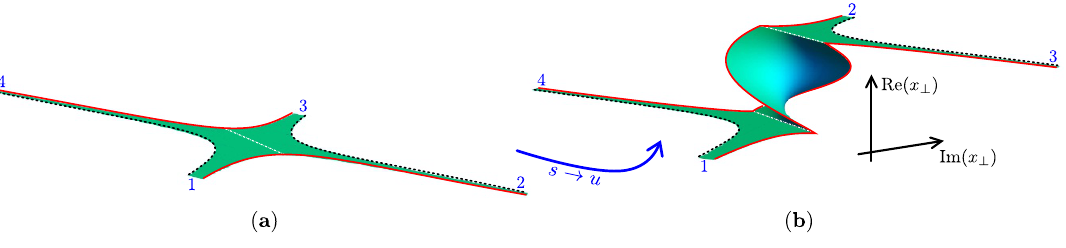
Figure 3 . Analytic continuation that connects the s - and u -channels. a) The original worldsheet with ordered external states Tr V 1 ( k 1 ) V 2 ( k 2 ) V 3 ( k 3 ) V 4 ( k 4 ) . b) The worldsheet after the analytic h i continuation s u . This new classical solution can be obtained from the amplitude with ordering → of points 2 and 3 is interchanged Tr V 1 ( k 1 ) V ⊺ ( k 2 ) V ⊺ ( k 3 ) V 4 ( k 4 ) in two steps. First, we cut it in the 3 2 h i middle of the t -channel and then insert a piece of the Lorentzian evolution. This Lorentzian piece contributes an imaginary piece to the Euclidean action. Its sign depends on the way we analytically continue s u →